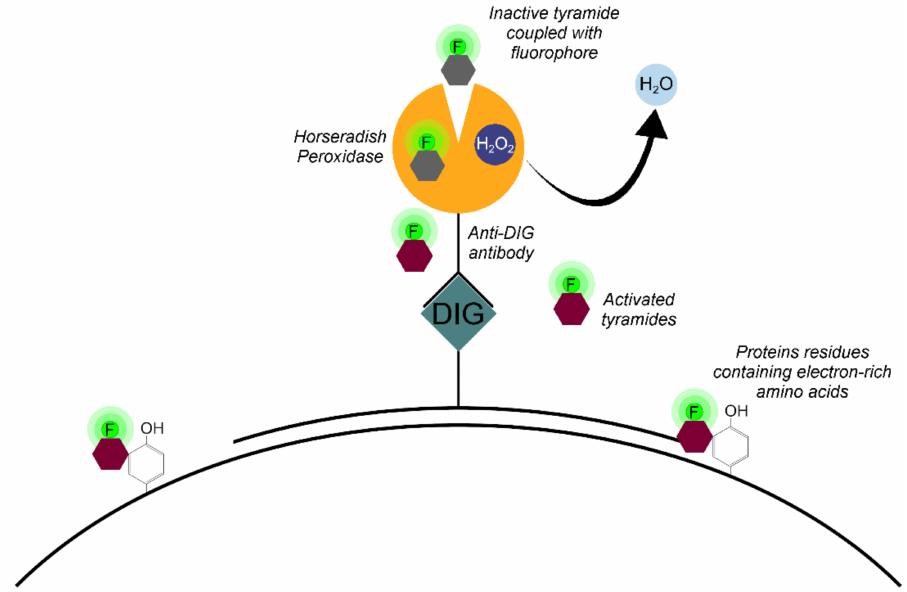
Figure 4. Principle of signal detection on physical chromosomes using horseradish peroxidase (HRP) and fluorophore- labeled tyramides.